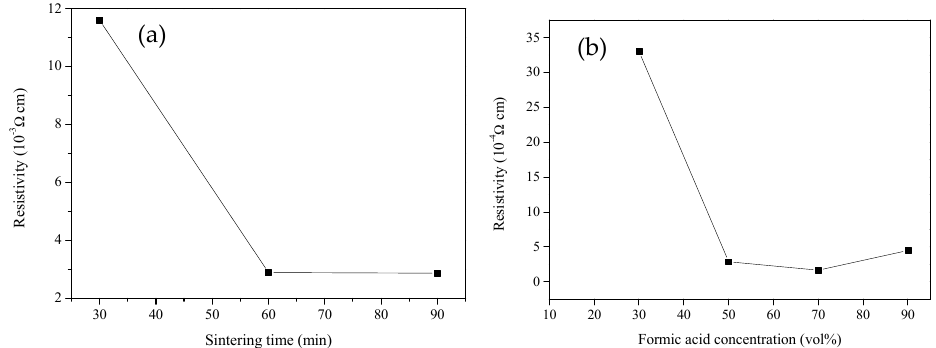
Figure 16. ( a ) Resistivity with sintering time. ( b ) Effects of different formic acid concentrations on resistivity.